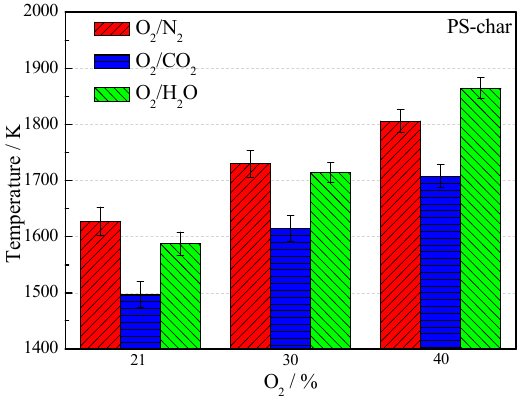
Figure 7. Average peak temperatures of chars of PS.